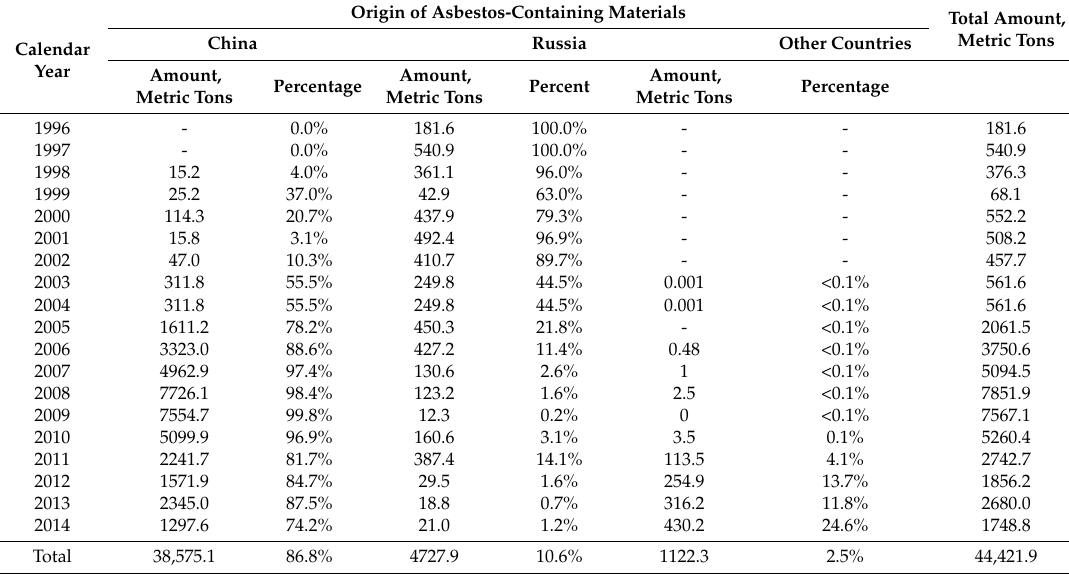
Table 1. Amount of imported asbestos-containing materials in Mongolia between 1996 and 2014.